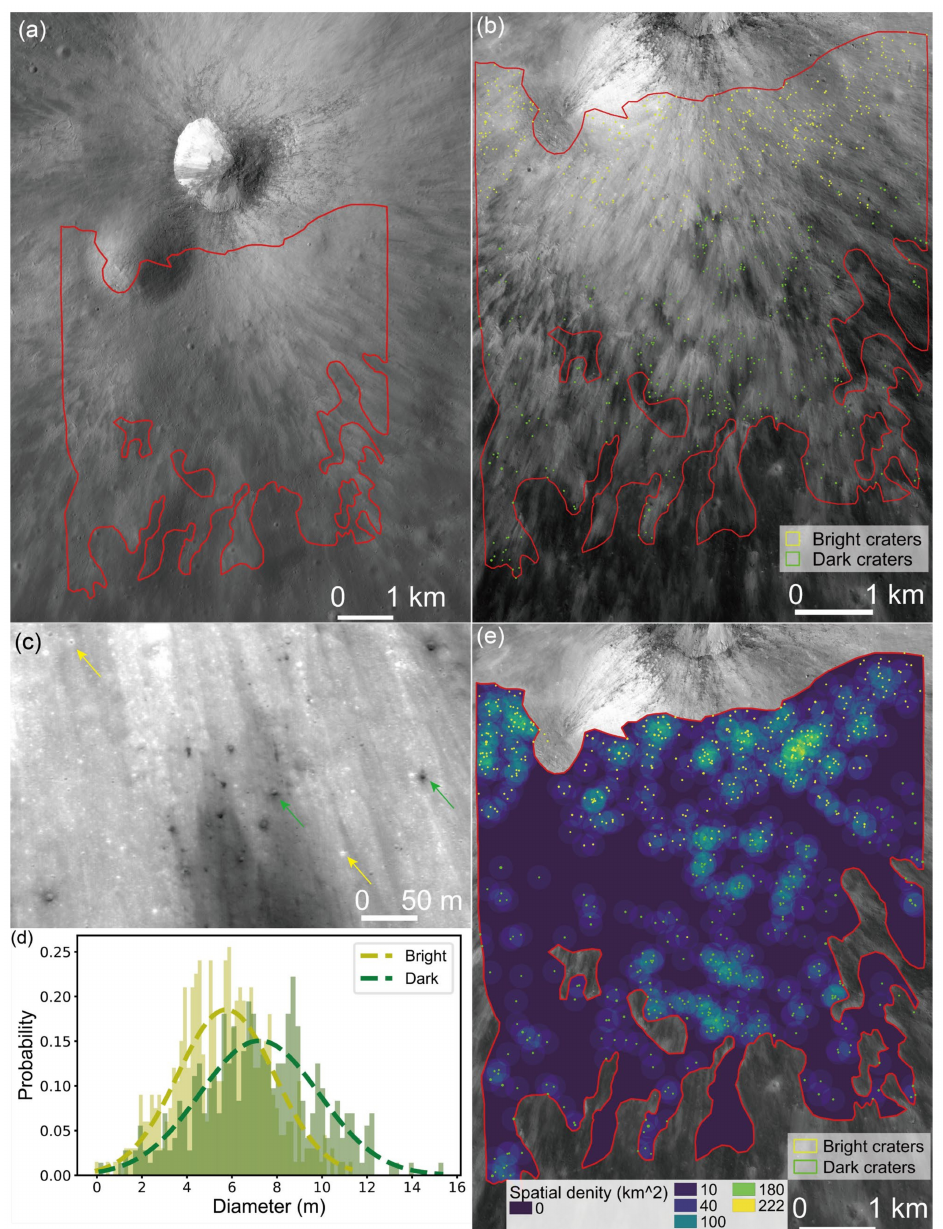
Figure 4. Spatial distribution of self-secondaries that have excavated materials with different reflectances on ejecta flows around a cold spot crater ( D = 1714 m; central coordinates 166.64 ◦ E, 19.38 ◦ N). Solar illumination is from the right, and north is up in all the panels. ( a , b ) Layers of ejecta deposits are visible around the cold spot crater, and the layers have different albedos (panel b). Craters with dark (green circles) and bright ejecta (yellow circles) are visible on the ejecta deposits. ( c ) Examples of dark (green arrows) and bright craters (yellow arrows) formed in the ejecta. ( d ) Diameters of the bright- and dark-toned self-secondaries. In the histogram, the bin width of crater diameters is 2 m. ( e ) Spatial density map of the bright- and dark-toned craters shows the clustered distribution. The green ( D > 4.5 m) and yellow circles ( D > 3.8 m) are the recognized small craters that have excavated dark and bright local materials, respectively. IDs of data used in this figure are compiled in the Supplementary